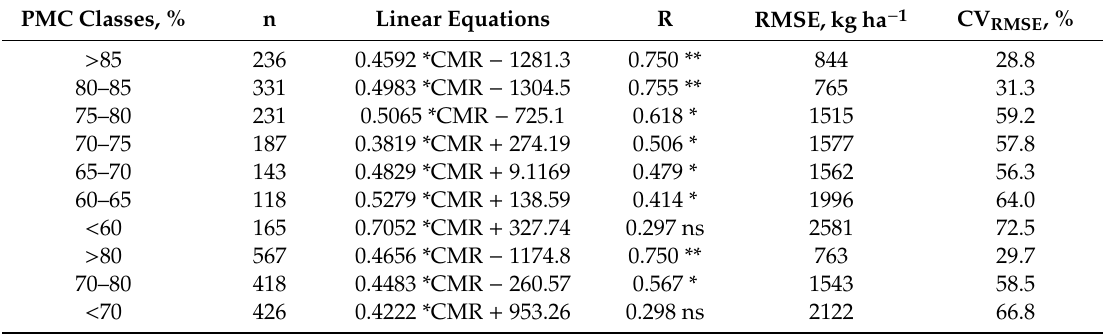
Table 5. Linear regression equations proposed to estimate pasture dry matter yield (DM), based on Grassmaster II measurements (CMR), for each pasture moisture content (PMC) class considered.